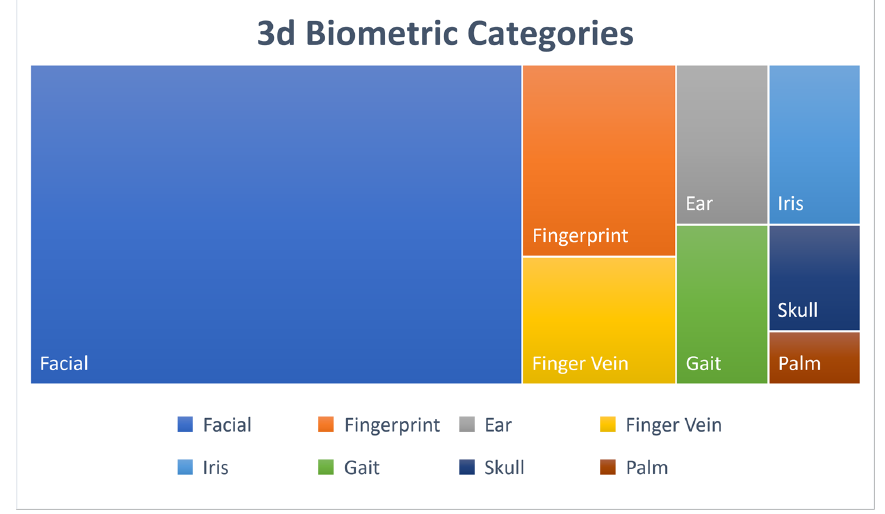
Figure 2. 3D Biometric Treemap.